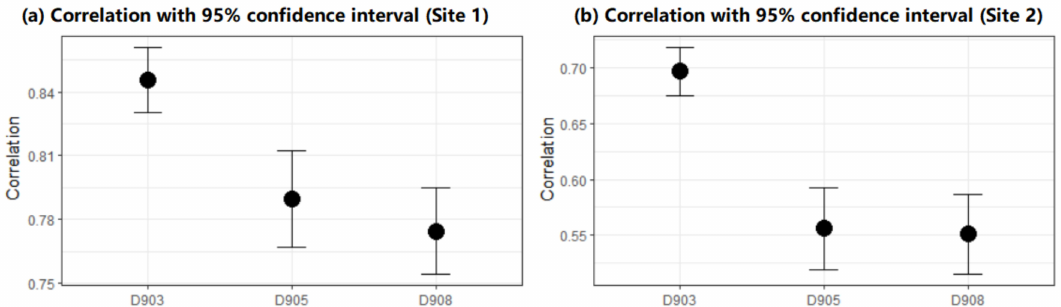
Figure 9. The mean and upper and lower correlations with 95% CI for INTEG-STRAT strategy with the sampling size ranging from 20 to 200 on three dates (( a ) is for site 1 and ( b ) is for site 2. The black points represent the mean value of correlation coefficients and short horizontal lines represent the upper and lower values with 95%